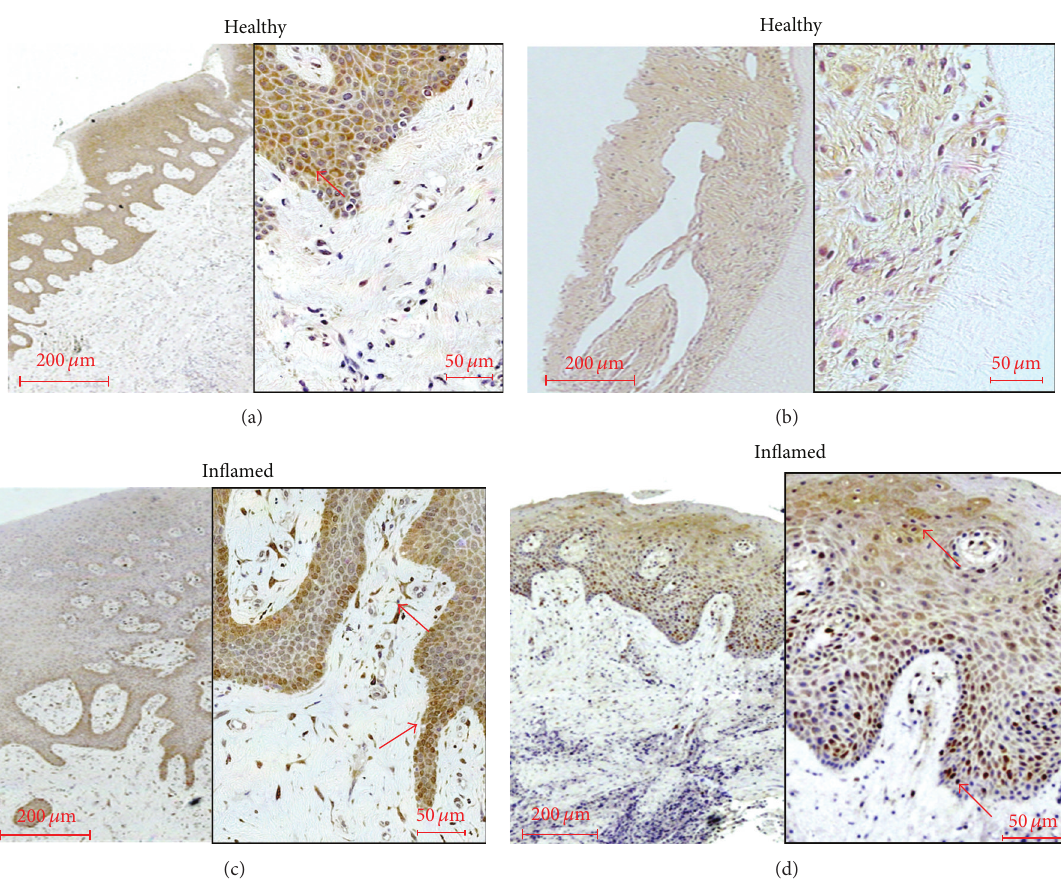
Figure 6: Superoxide dismutase (SOD) occurrence in healthy and inflamed human tissue. Healthy gingival epithelium (a), periodontal ligament (b), and samples of gingivitis (c) or periodontitis (d) were obtained after the approval of the Ethics Committee of the University of Bonn and parental as well as patient’s allowance ( 𝑛 = 3 ). Polyclonal primary antibody against SOD (Abcam, Cambridge, UK) was used in a concentration of 1: 100. Gingival epithelium showed a moderate to strong staining of SOD in keratinocytes which was primarily limited to the cytosol (Figure 6(a) and red arrow depicts the typical localization). In the healthy periodontium, gingival and PDL fibroblasts were weakly stained (Figure 6(b)). In inflamed tissues, basal epithelial cells seemed to be stained more intensively in the gingivitis specimen than in periodontitis (Figures 6(c) and 6(d)). In addition, the subepithelium revealed immunoreactivity in local cells like gingival fibroblasts and scattered immune cells (Figure 6(c), see red arrow). In periodontitis, SOD immunostaining seemed to be limited to the gingival epithelium (Figure 6(d); see red arrow). The scale bars indicate 200 𝜇 m in the surveys and 50 𝜇 m in the higher magnifications,